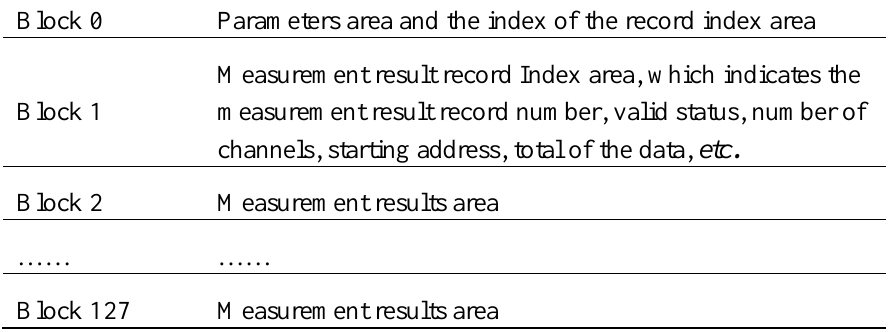
Table 1. Memory allocations in the 25LC256 memory